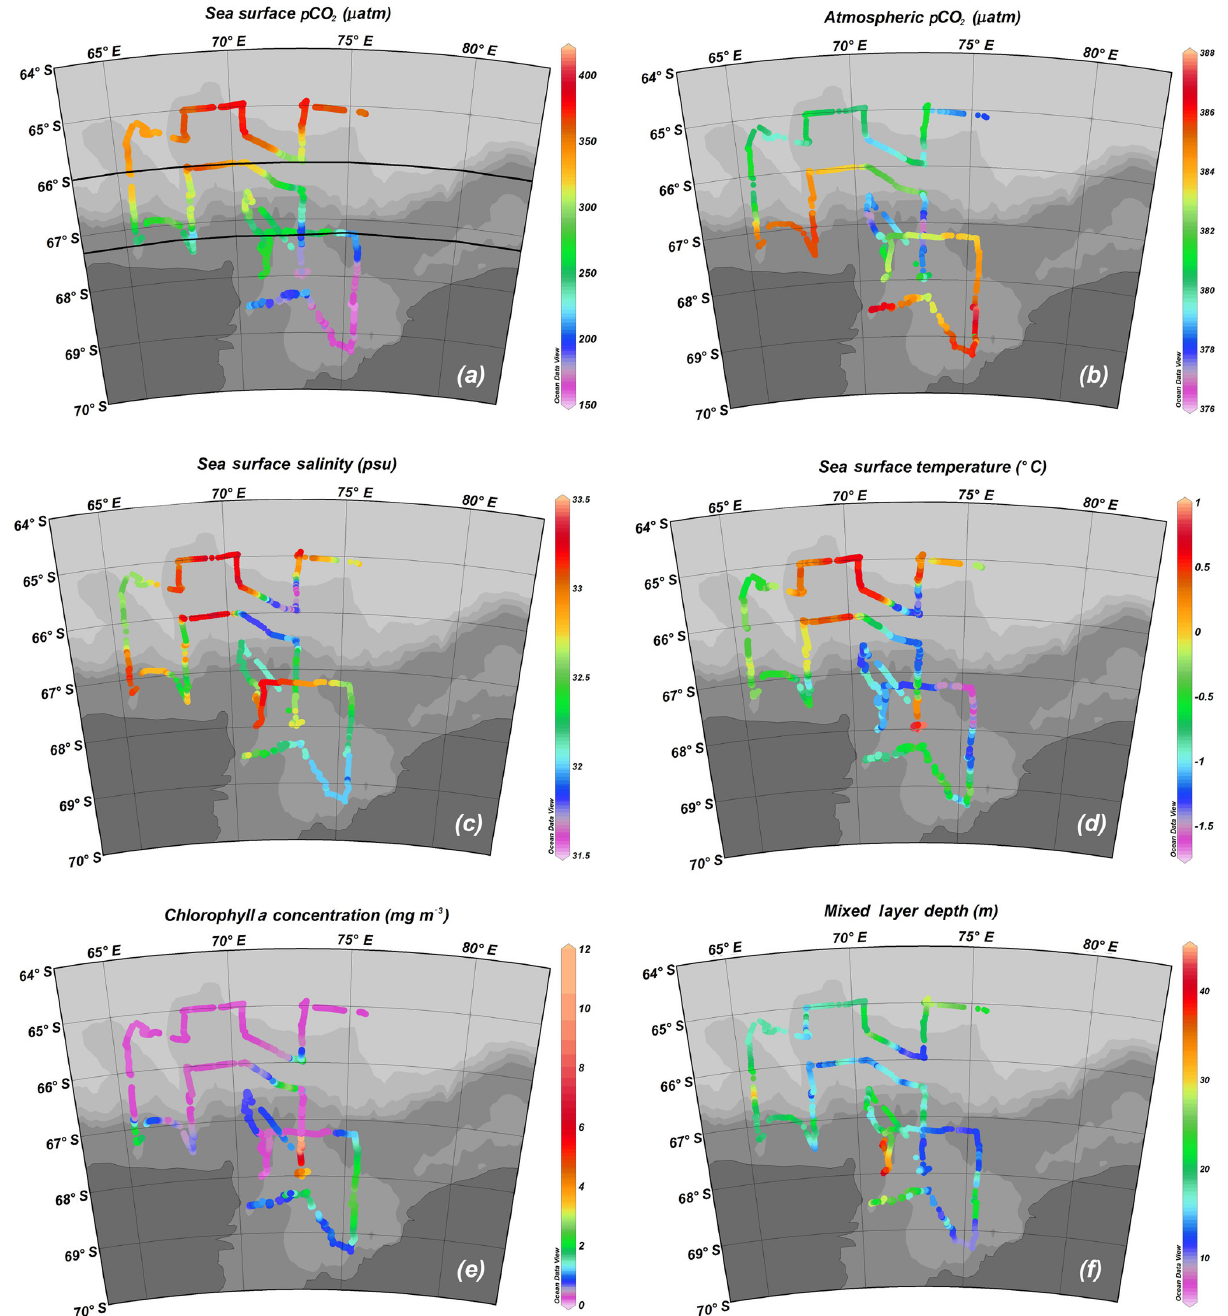
Figure 2. The distributions of underway oceanic and atmospheric p CO 2 , SST, SSS and CHL gridded from MODIS, in addition to MLD gridded from station surveys, from February to early